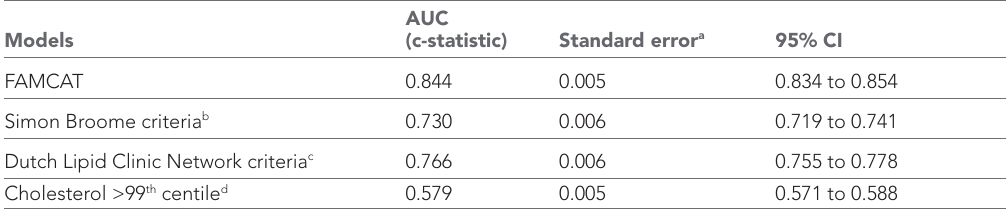
Table 2 Model discrimination in the external validation cohort for identifying familial hypercholester-